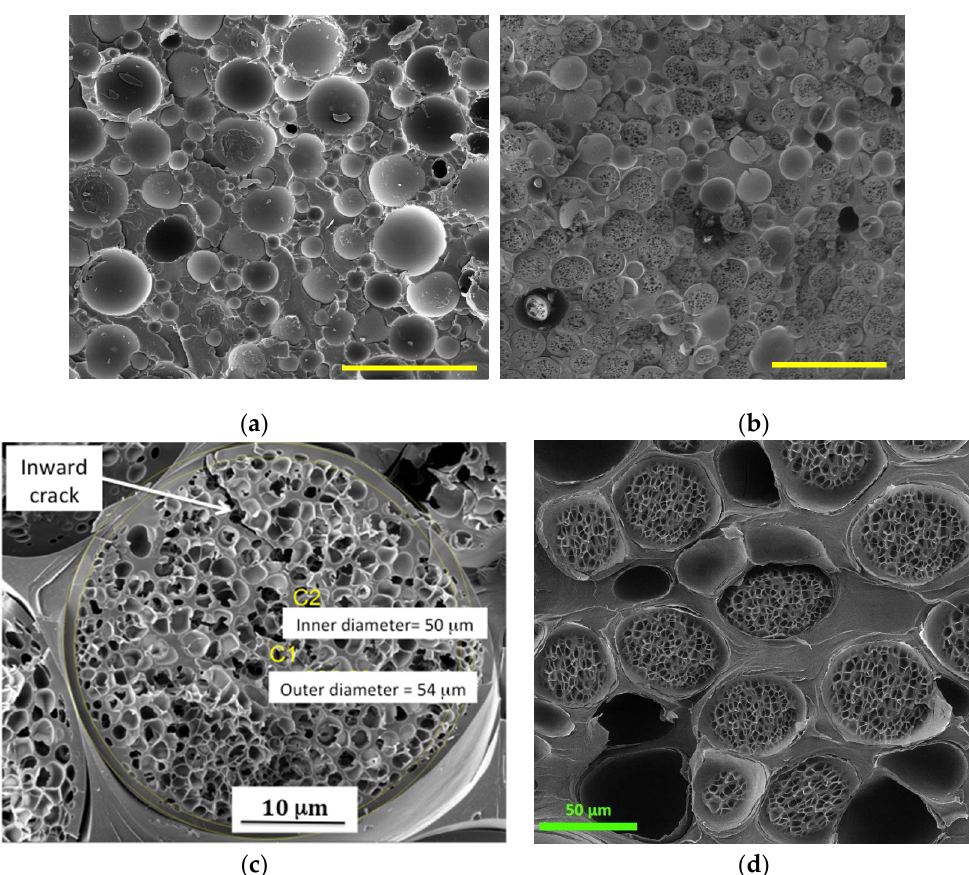
Figure 4. ( a ) SEM micrograph of the traditional syntactic foam consisting of the poly-methyl-methacrylate (PMMA) filled with hollow glass microspheres. ( b ) SEM micrographs of the PMMA/(PMMA/nMg(OH) 2 ) syntactic foam with glassy cellular micro-particles (CMPs). ( c ) SEM micrograph of the glassy CMP in the PMMA syntactic foam broken in liquid nitrogen. In average, the CMPs consist of approximately 2 µm thick wall and cellular core, in which the pore size gradually increases inwards. An inward crack initiated in the solid shell and propagated into the cellular core where it went to an arrest is depicted in the top of the CMP. ( d ) The syntactic foam with rubbery CMPs embedded in the polypropylene impact copolymer (ICPP) matrix.